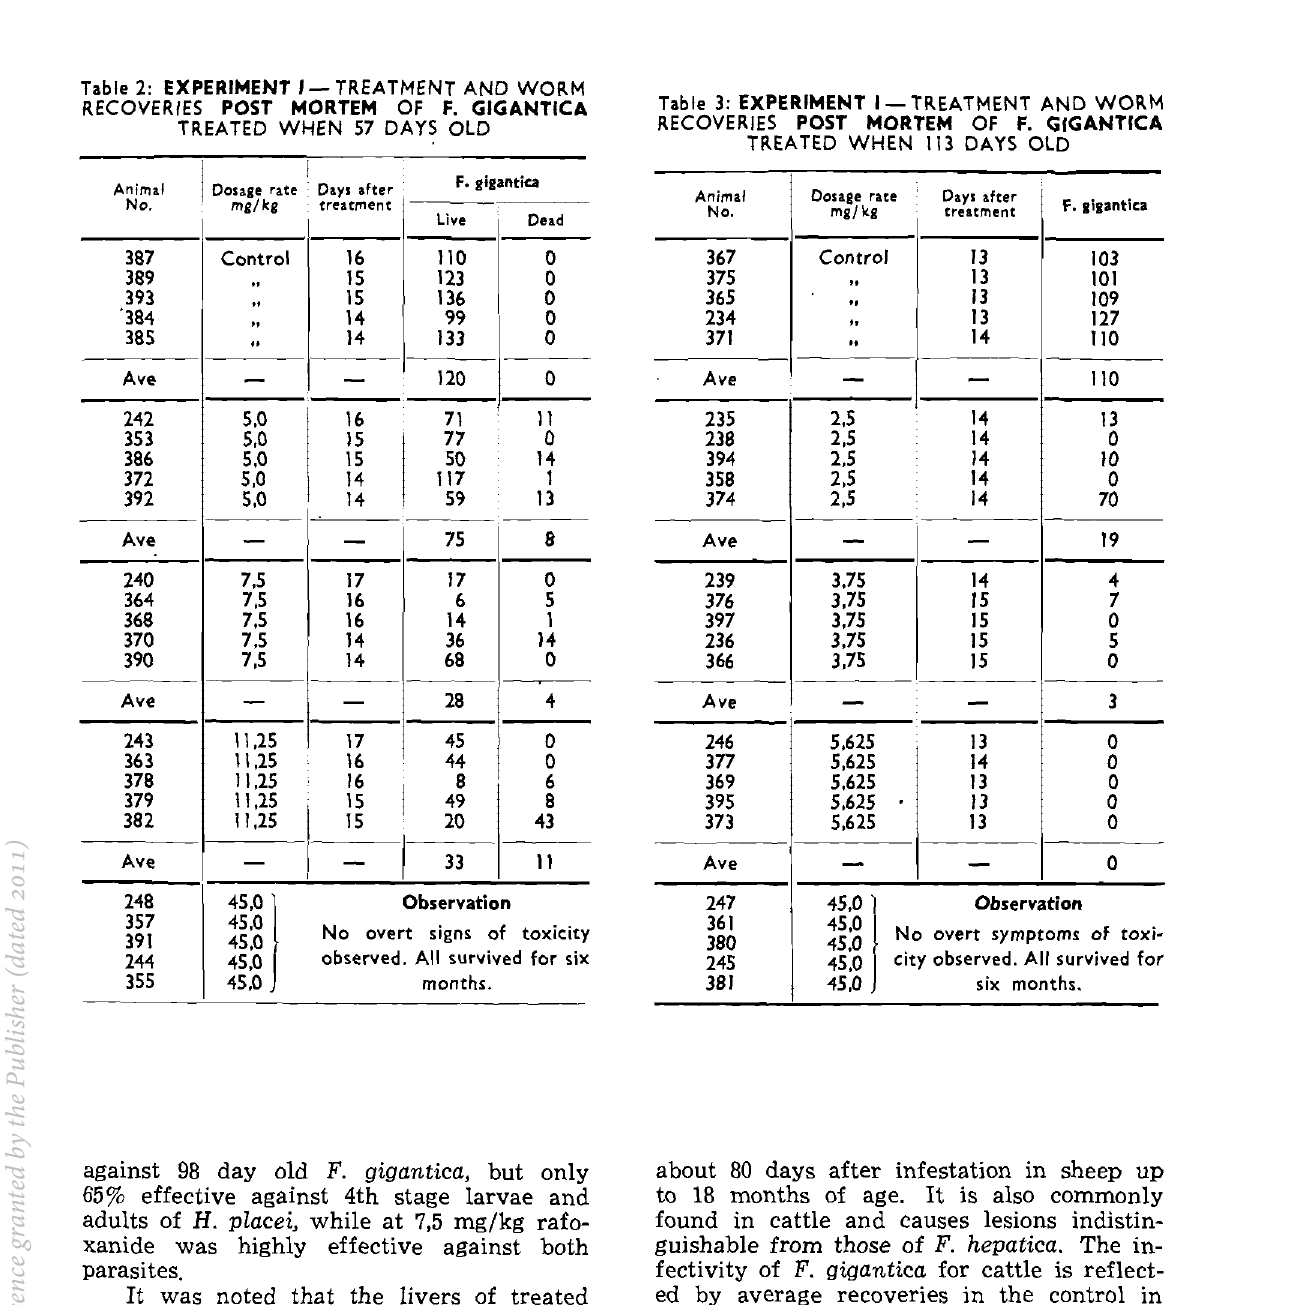
Table 2: EXPERIMENT 1- TREATMENT AND WORM Table 3: EXPERIMENT 1- TREATMENT AND WORM RECOVERIES POST MORTEM OF F. GIGANTICA RECOVERIES POST MORTEM OF F. GIGANTICA TREATED WHEN 57 DAYS OLD TREATED WHEN 113 DAYS OLD I F. gigantica Animal Dosage rate Day. after Animal Do.ago rate Day. after F. gigantica No. mg/kg treatment No. Livo Dead